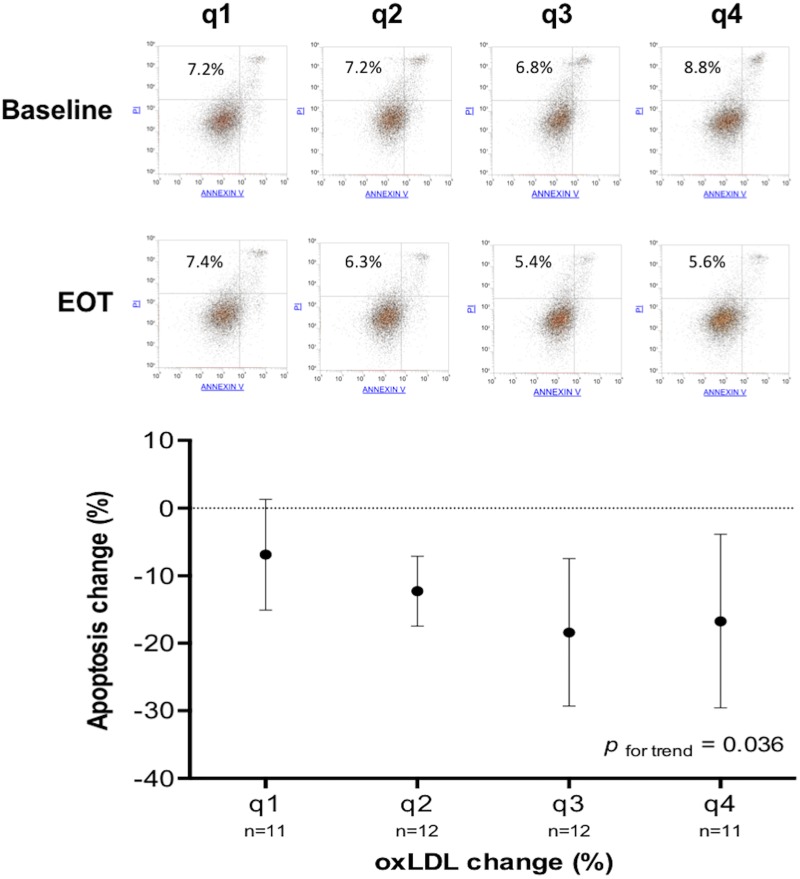
Change of apoptosis rate according to quartiles of oxLDL change. In the main graph, for each quartile of oxLDL change (q1 > −8.78%; q4 < −34.66%) is shown the mean and SD of apoptosis rate change. The upper part of the figure shows the flow cytometry and apoptosis rate (%) before and after treatment of four representative subjects belonging to different quartiles of oxLDL change.